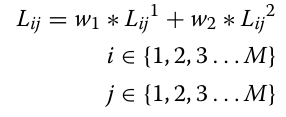
Fig. 10 An example of a matching in a bipartite graph. Each node represents a geographic area in a geographic area group. Green lines are one of the matching